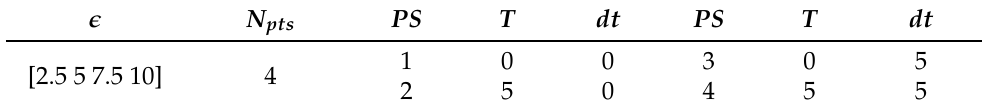
Table A3. The 16 tested parameter of MAP-DBSCAN method for the three datasets D1, D2 and D3.